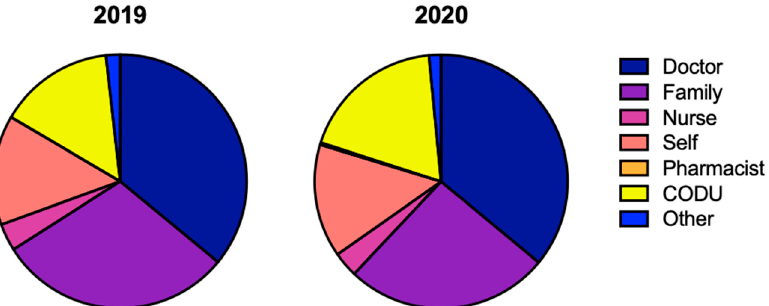
Figure 1. Characterization of the contact person to the Poison Information Centre in the Algarve region in 2019 and 2020. Comparing 2019 and 2020, the distributions were as follows: doctor (35.96% vs. 35.99%), family (30.01% vs. 26.05%), nurse (3.49% vs. 3.22%), self (13.97% vs. 14.43%), pharmacist (0% vs. 0.28%), CODU (14.75% vs. 18.49%), other (1.81% vs. 1.54%). Abbreviations: CODU—Urgent Patient Orientation Centre, from the Portuguese Centro de Orientação de Doentes Urgentes .